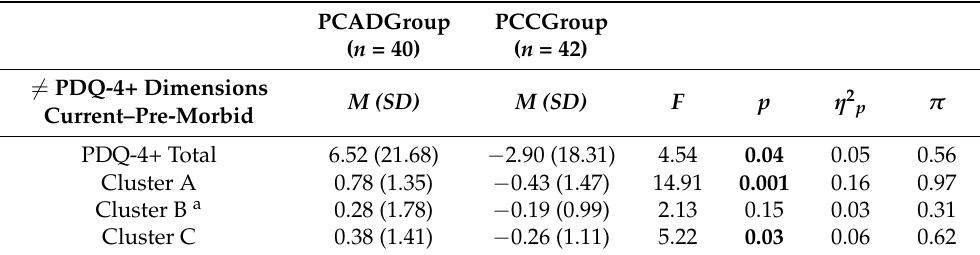
Table 4. Analysis of Variance (ANOVA) of the Personality Changes AD Group (PCADGroup) and the Personality Changes Control Group (PCCGroup) on the PDQ-4+ between Current and